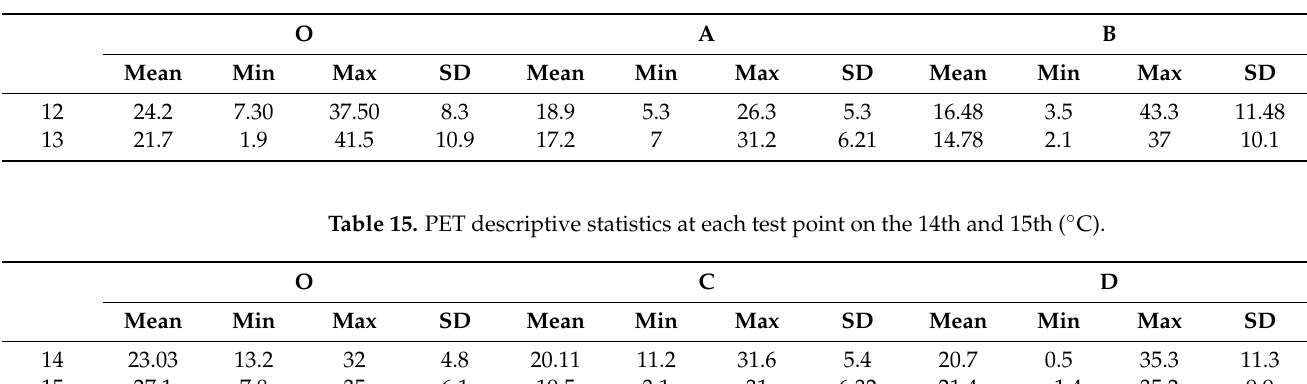
Table 14. PET descriptive statistics at each test point on the 12th and 13th ( ◦ C).